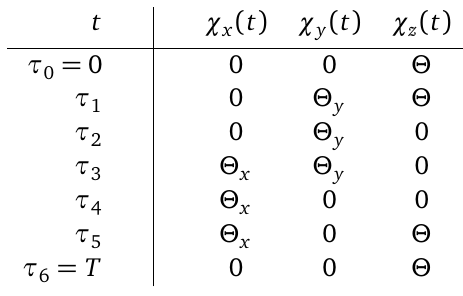
Table 1: Values of the coupling strengths χ α = 0,...,6) along the closed loop shown in Fig.